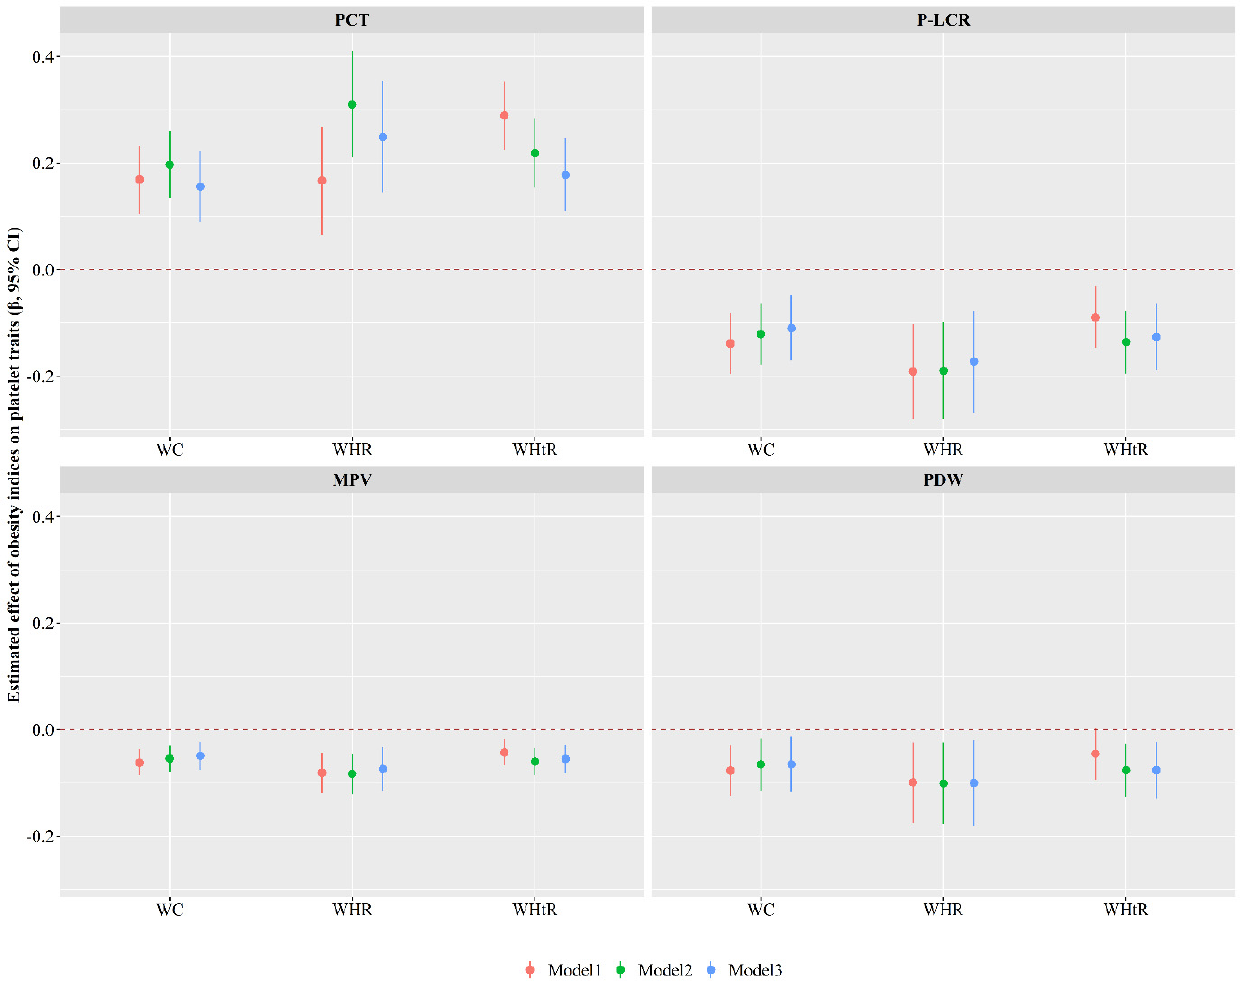
Figure 5. Associations of obesity indices with platelet traits. Model 1 was the crude model; Model 2 was adjusted for individuals’ demographic characteristics (such as age, sex, personal average monthly income, marital status, and educational attainment) and lifestyle behaviors (such as physical activity, drinking and smoking status, vegetable and fruit intake, and high fat diet); Model 3 was additionally adjusted for hypertension, type 2 diabetes mellitus, dyslipidemia, and family histories of diseases including hypertension, hyperlipidemia, and diabetes. MPV: mean platelet volume; PCT: